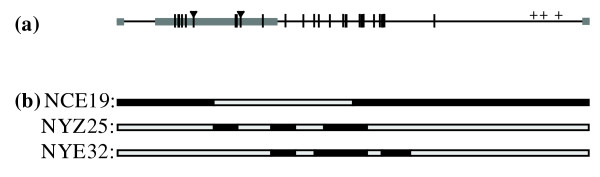
Differences between clades and estimated recombination breakpoints. (a) Fixed differences between clades A and B. The region shown is from bp 415 to bp 771, with exons represented as gray bars and introns as horizontal black lines. Vertical dashes represent fixed differences between the A and B clades. Triangles above exon positions 224 and 363 mark the two amino acid substitutions. "+" symbols indicate three polymorphisms that would be fixed differences except for one allele in NCZ26. (b) Recombination breakpoints for sequences NCE19, NYZ25, NYE32. These inferred recombinant alleles share similarity to both clades A and B for different parts of the Δ11 desaturase gene region. Light bars indicate identity to clade A, and dark bars indicate identity to clade B. Recombination breakpoints are estimated from the fixed differences between clades A and B and are displayed as the midpoint between two fixed differences for which the recombinant's haplotype changes from one clade to the other. Most stretches of similarity are supported by multiple fixed differences (compare to (a) to see how many sites (vertical dashes) support that stretch of similarity). Two inferred recombination events are supported by only one nucleotide change and may represent point mutations.